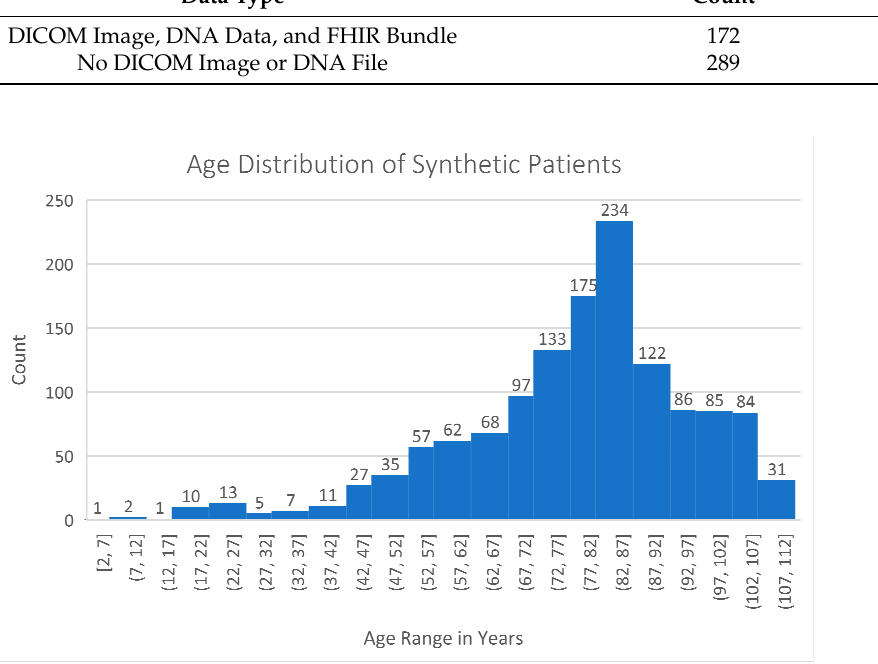
Figure A1. Distribution of synthetic patients by age grouping.